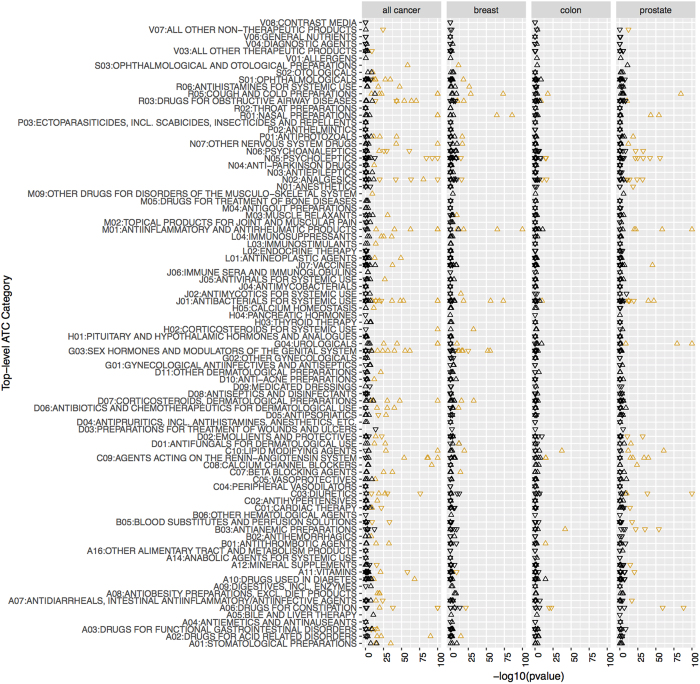
Manhattan plots (−log10(p-value)) for each drug categorized by Anatomical Therapeutic Chemical anatomical main group) in Cox analyses by cancer type.Orange color denotes tentative signals. P-values lower than 1 × 10−100 set to 1 × 10−100 for clarity. Upward triangles indicate HR >1 and downward triangles HR <1.